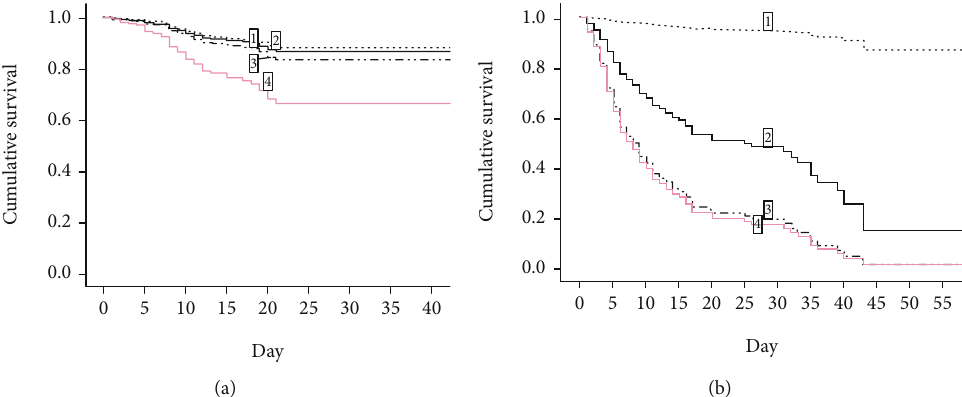
Figure 1: Survival functions, determined by Cox regression analysis, of participants strati fi ed according to levels of procalcitonin on admission (level 1: < 0.05ng/ml; level 2: ≥ 0.05 and < 0.5ng/ml; level 3: ≥ 0.5 and < 2 ng/ml; level 4: ≥ 2ng/ml) and age ((a) age ≤ 75 yearsold ; (b) age > 75 yearsold